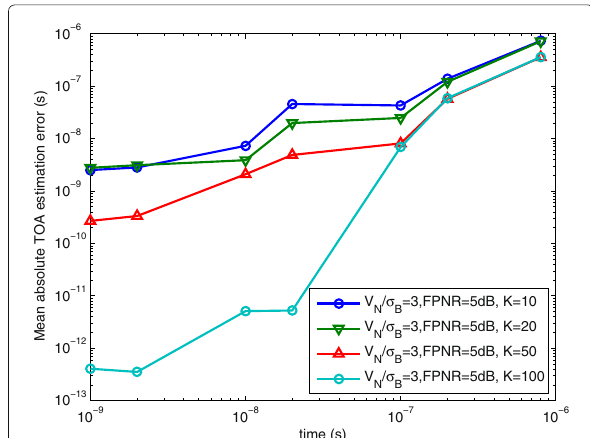
Fig. 10 TOA estimation error for different numbers of TOA measurements